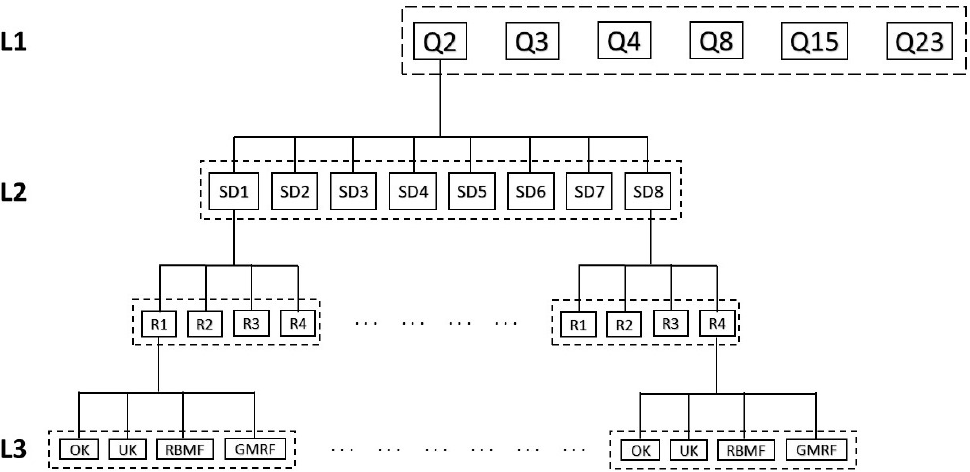
Figure 7. Factorial ANOVA test scheme applied in this study for the sector Q2. L1: level 1 (morpho- logical complexity). L2: level 2 (sampling density). L3: level 3 (interpolation method). This factorial flowchart is repeated for each sector.